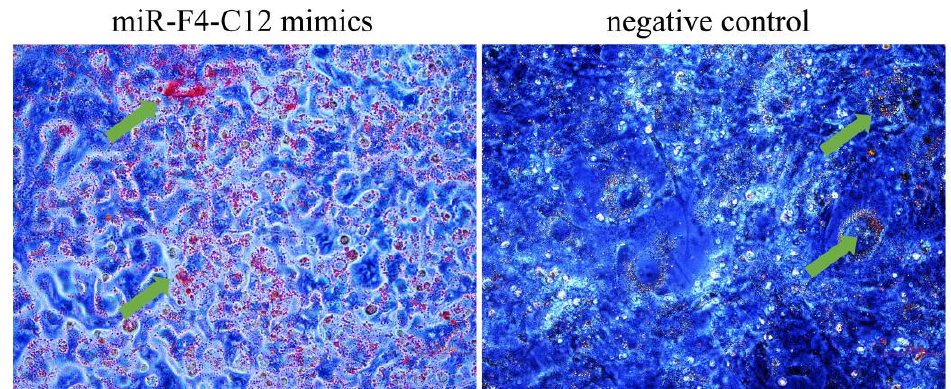
Figure 3. The overexpression of miR-F4-C12 promoted the differentiation of 3T3-L1 cells. Oil red staining showed increased lipid droplets in 3T3-L1 cells in the miR-F4-C12 overexpression group compared with the negative control group. Green arrows indicate red lipid droplets.